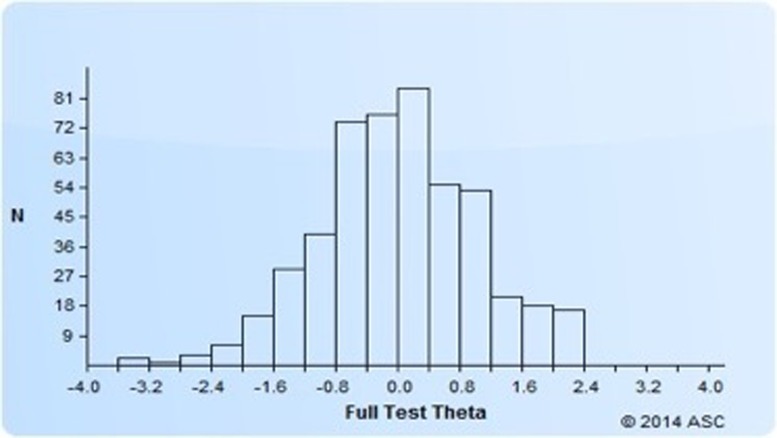
Theta estimates for all calibrated items.